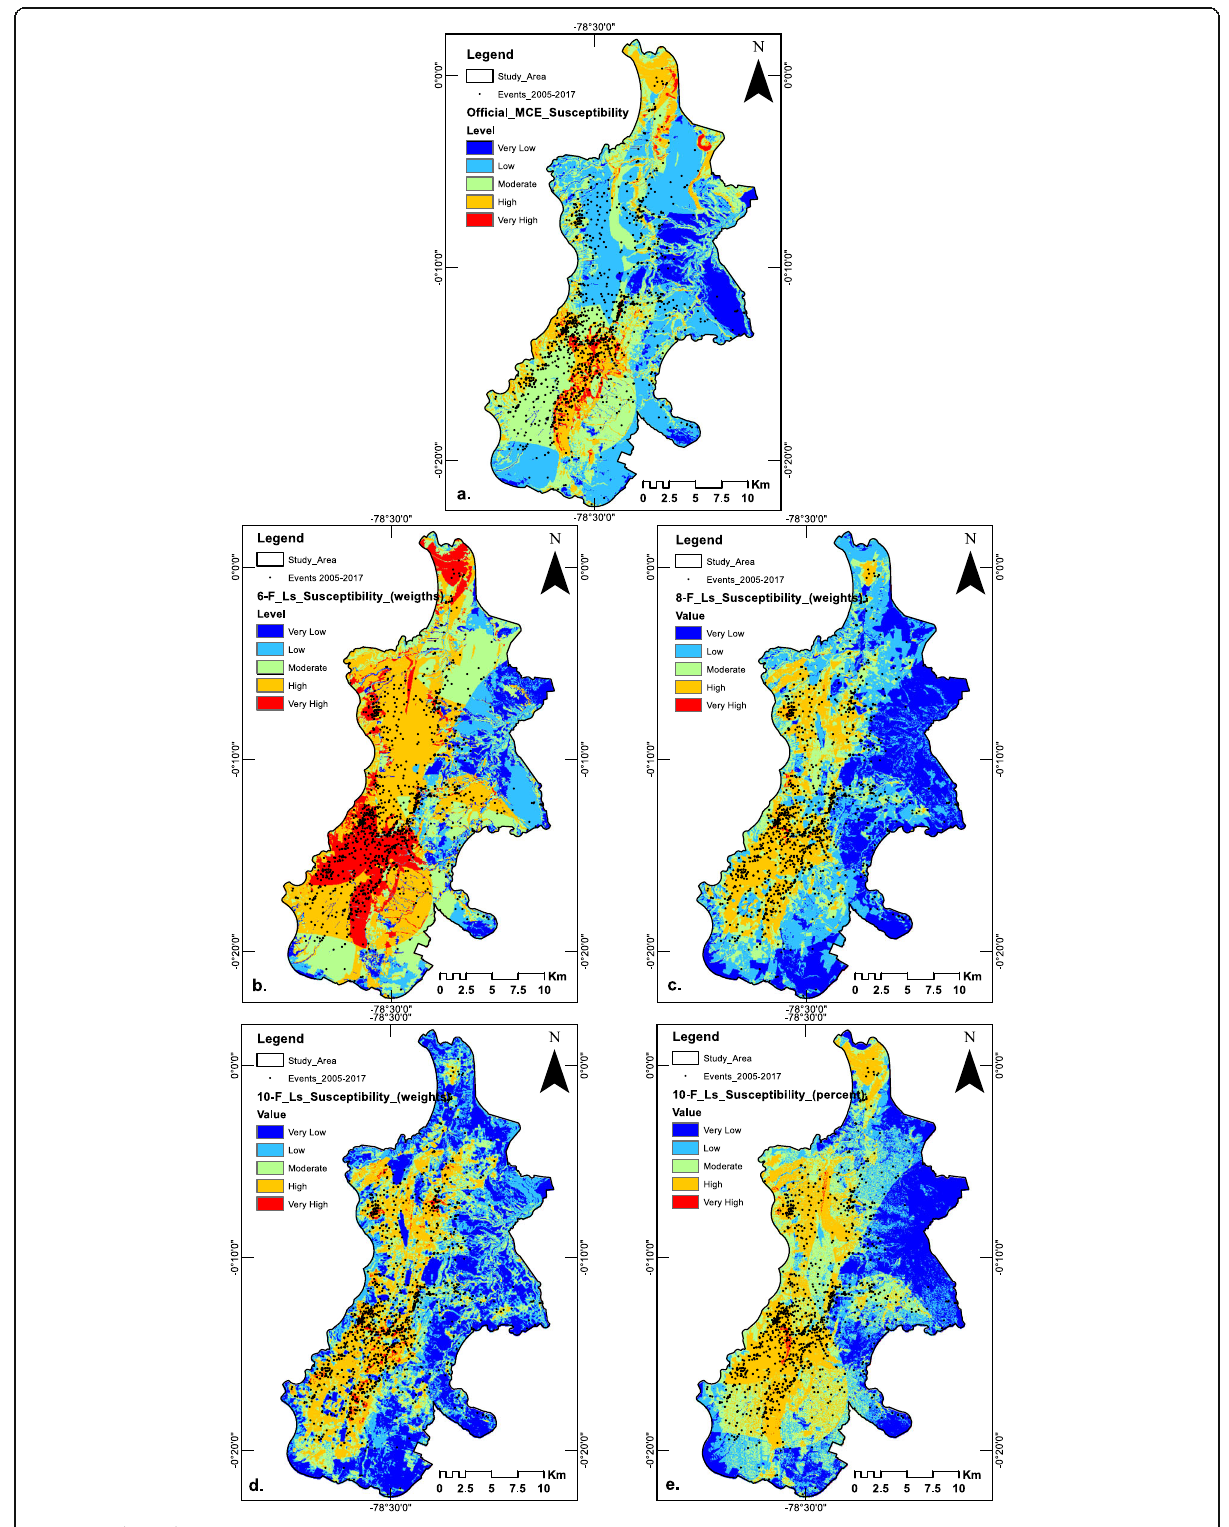
Fig. 3 (See legend on next